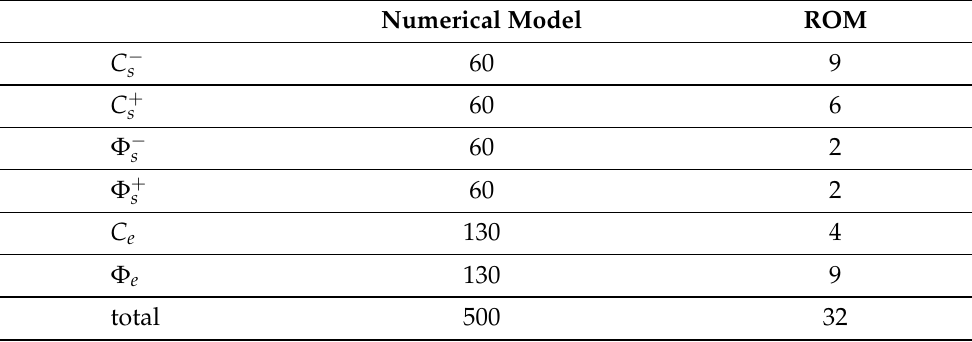
Table 1. DMDc approximation orders used for the model with parameters given in Appendix